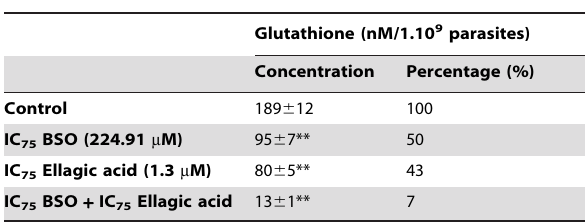
Table 3. Determination of reduced glutathione in treated and untreated P. falciparum.